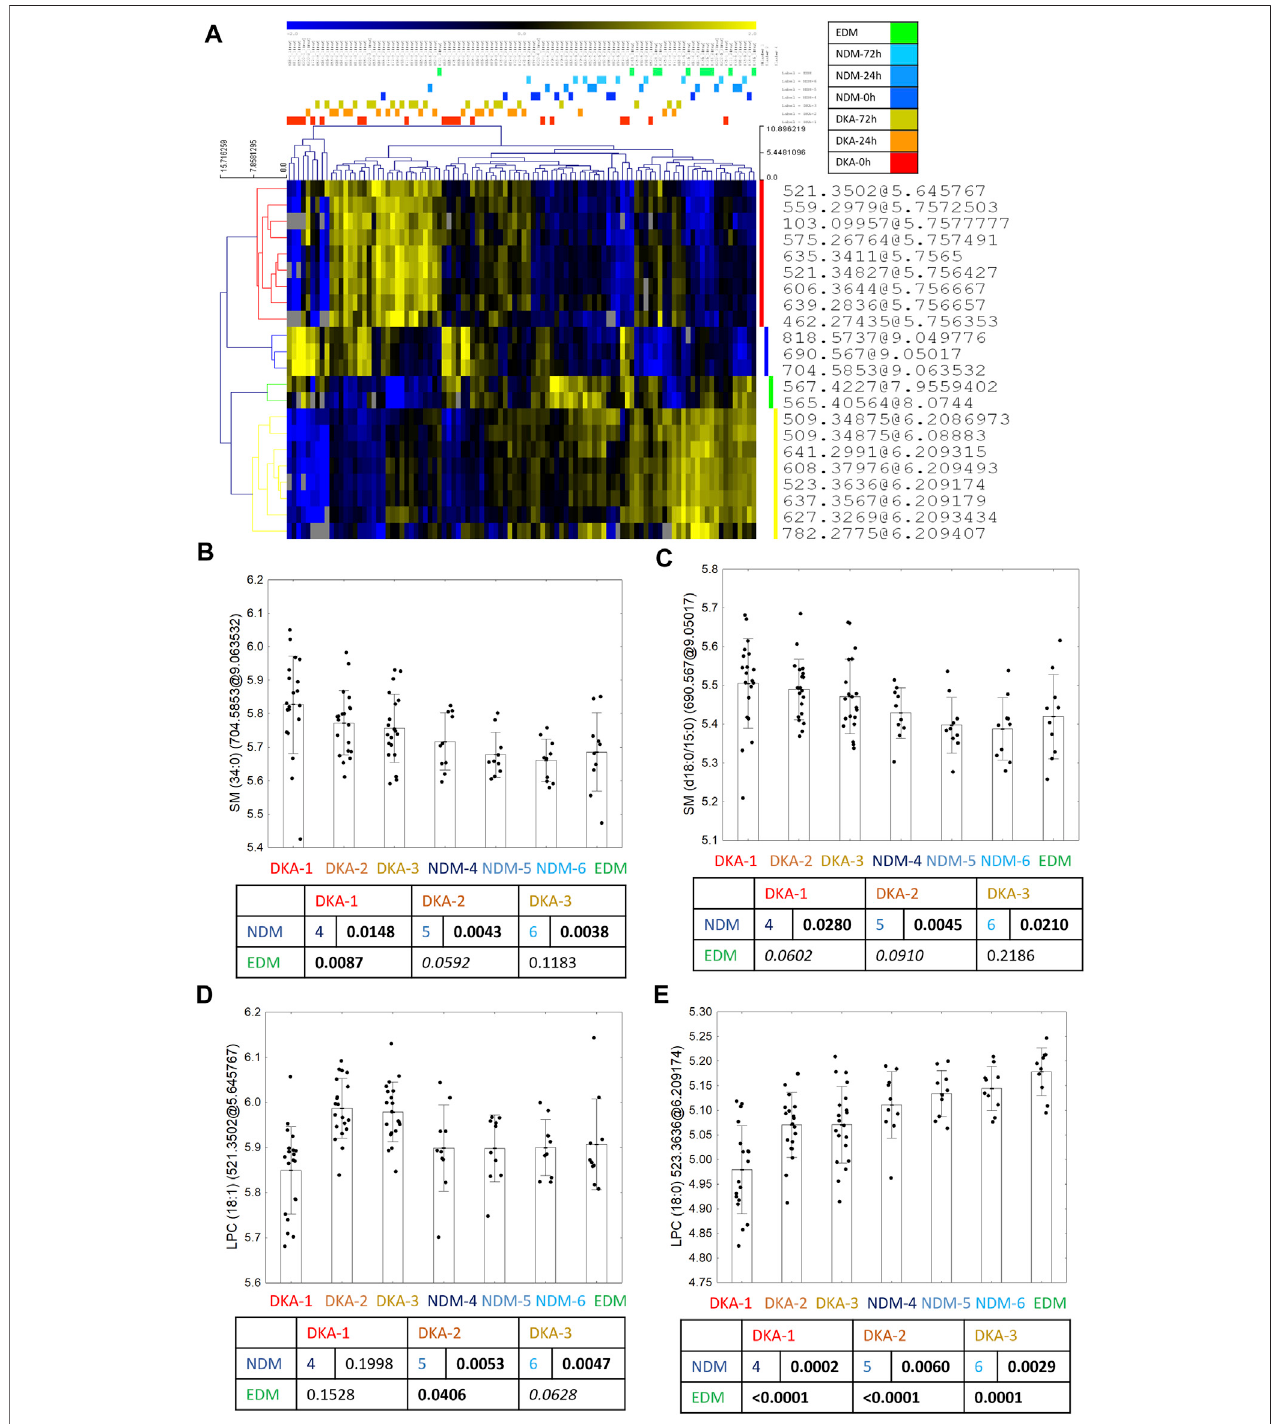
FIGURE 2 | Twenty-two metabolic features selected in the statistical analysis as biomarkers of DKA occurrence (A) . Between the group pro fi le of identi fi ed metabolites: SM (34:0) (B) , SM (d18:0/15:0) (C) , LPC (18:1) (D) and LPC (18:0) (E) . Uncorrected t -test p values are shown in the graphs.